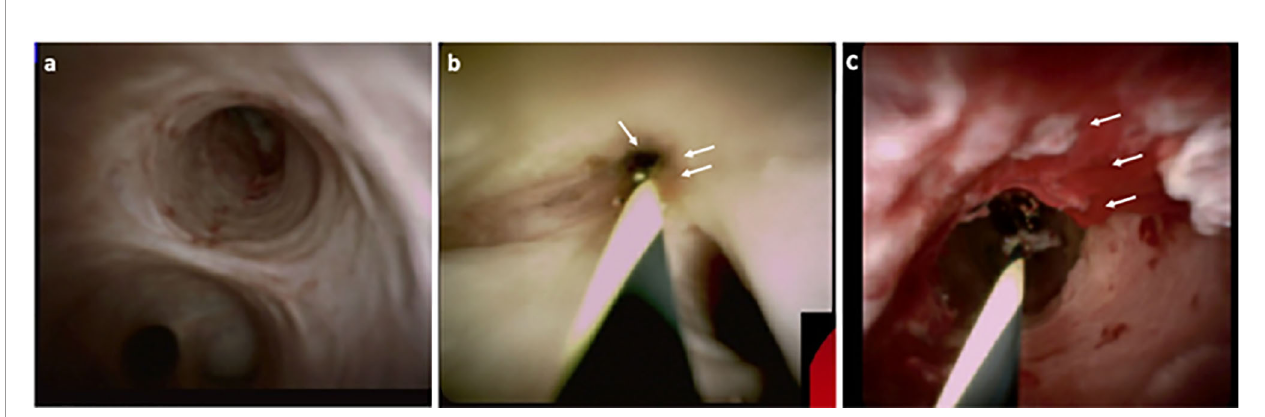
FIGURE 2 | Direct visualisation of the biliary epithelium using cholangioscopy, in healthy (A) , PSC stricture (B) and CCA (C) . Characteristics such as surface irregularity, fi lling defects, nodularity and neovascularisation ( C – white arrows) are often indicative of malignancy, with high positive